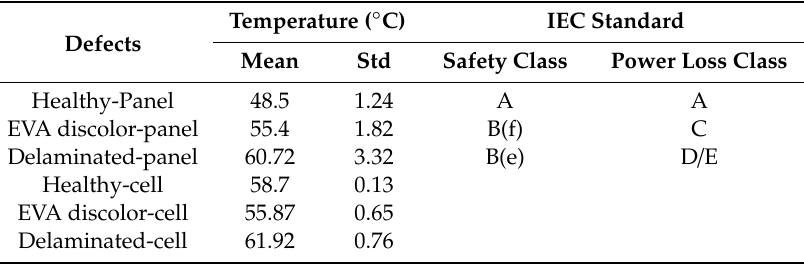
Figure 4. Flow chart for the proposed TPC algorithm. Table 4. Mean and std of the temperature matrix of the PV panel and cell. Defects